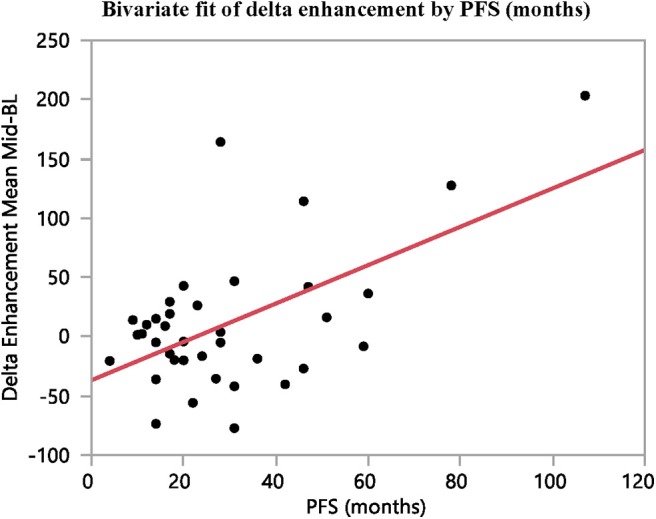
The difference in contrast-enhancement during early stages of treatment (baseline to mid-treatment) correlates with PFS (n = 37, R2 = 0.33, p = 0.0002).